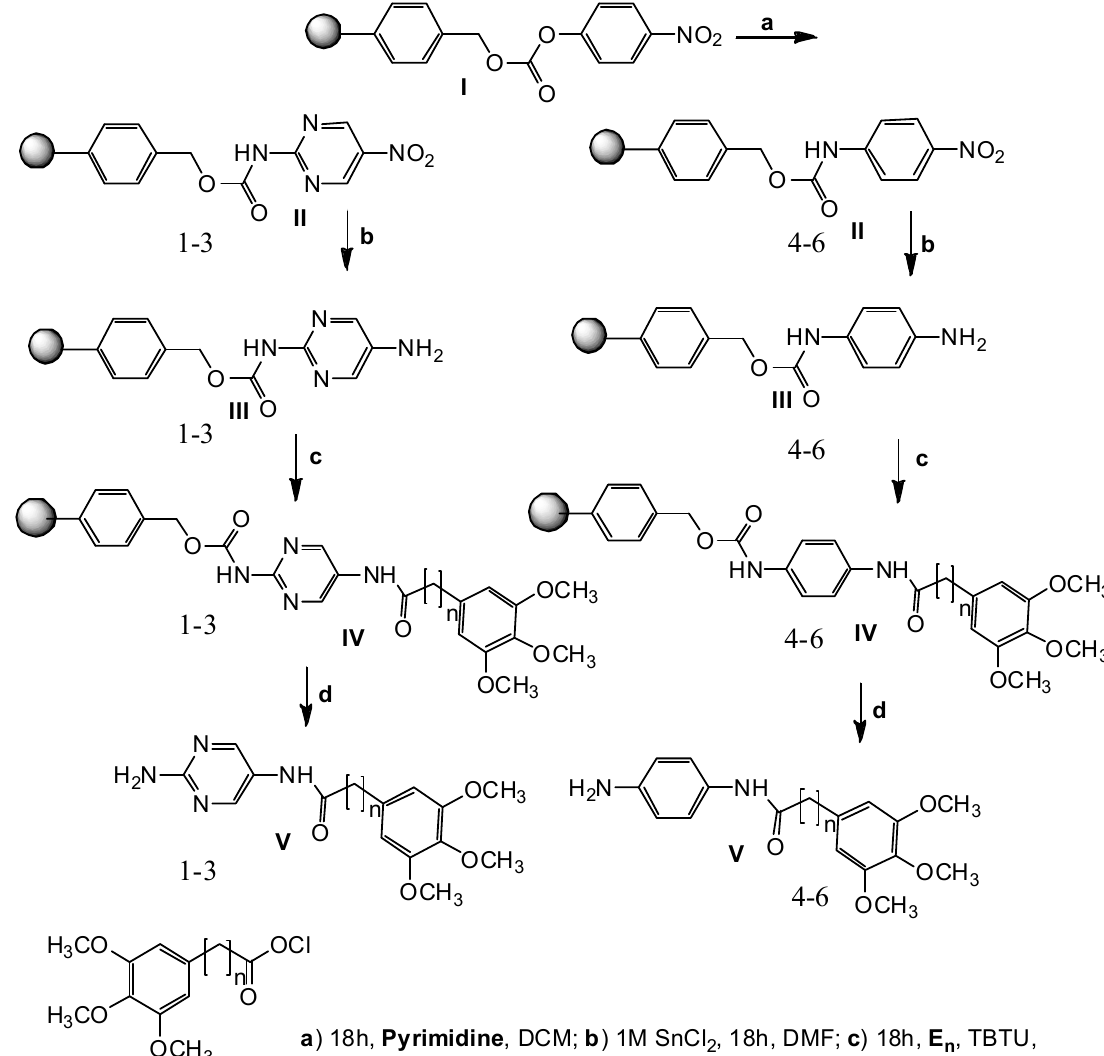
Figure 3. Scheme of solid phase synthesis of 1 – 6 analogues of TMP .